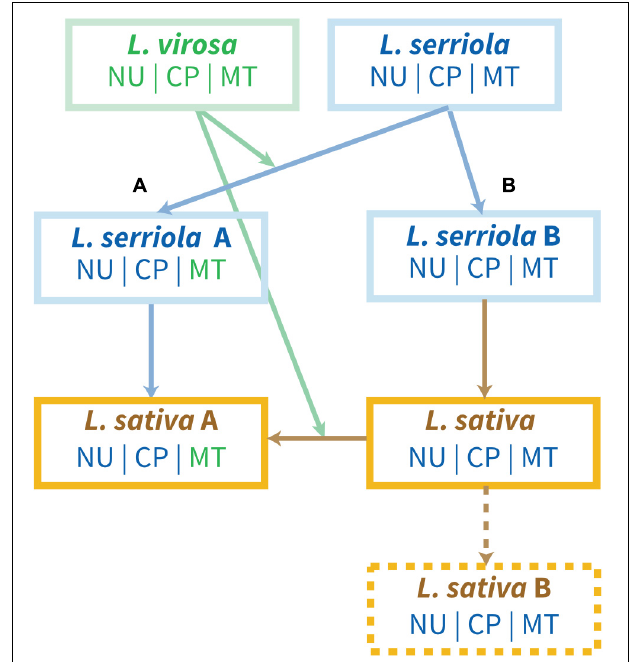
FIGURE 7 | Hypothesis for the introgression of L. virosa mtDNA in L. sativa . Hypothesis (A) postulates a single introgression of L. virosa before the domestication of L. sativa . Hypothesis (B) involves introgression of L. virosa during the diversification of L. sativa . L. serriola US96UC23 could correspond to L. serriola “A”; L. serriola CGN004799 and LAC05780B to L. serriola “B”; L sativa “A” corresponds to all L. sativa mtDNA sequences available to date; L. sativa “B” remains hypothetical. NU, nuclear genome; CP, cpDNA; MT, mtDNA. Their origins are color-coded.